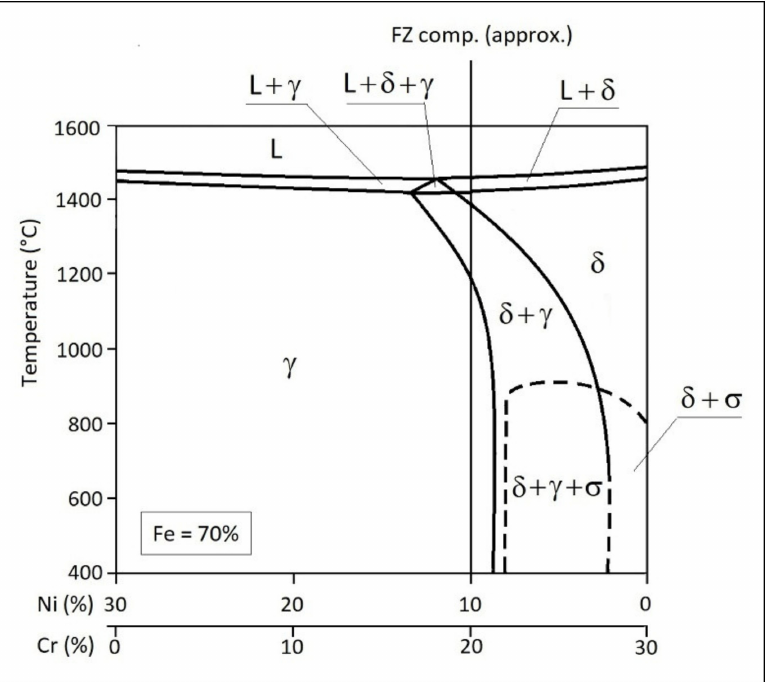
Figure 6. Vertical section of the ternary phase diagram Fe-Cr-Ni, at Fe = 70% [33]. Solidification as primary ferrite (FA mode) has been shown to ensure better resistance to weld solidification cracking than the other modes. In general, austenitic stainless steels tend to be less susceptible to solidification cracking if the primary solidification phase is ferrite- δ . The main reason is the presence of ferrite–austenite boundaries at the end of solidification, which resists wetting by liquid films and presents a tortuous path (see Figure 7), along which cracks have more difficulty propagating than if they were straight and smooth.